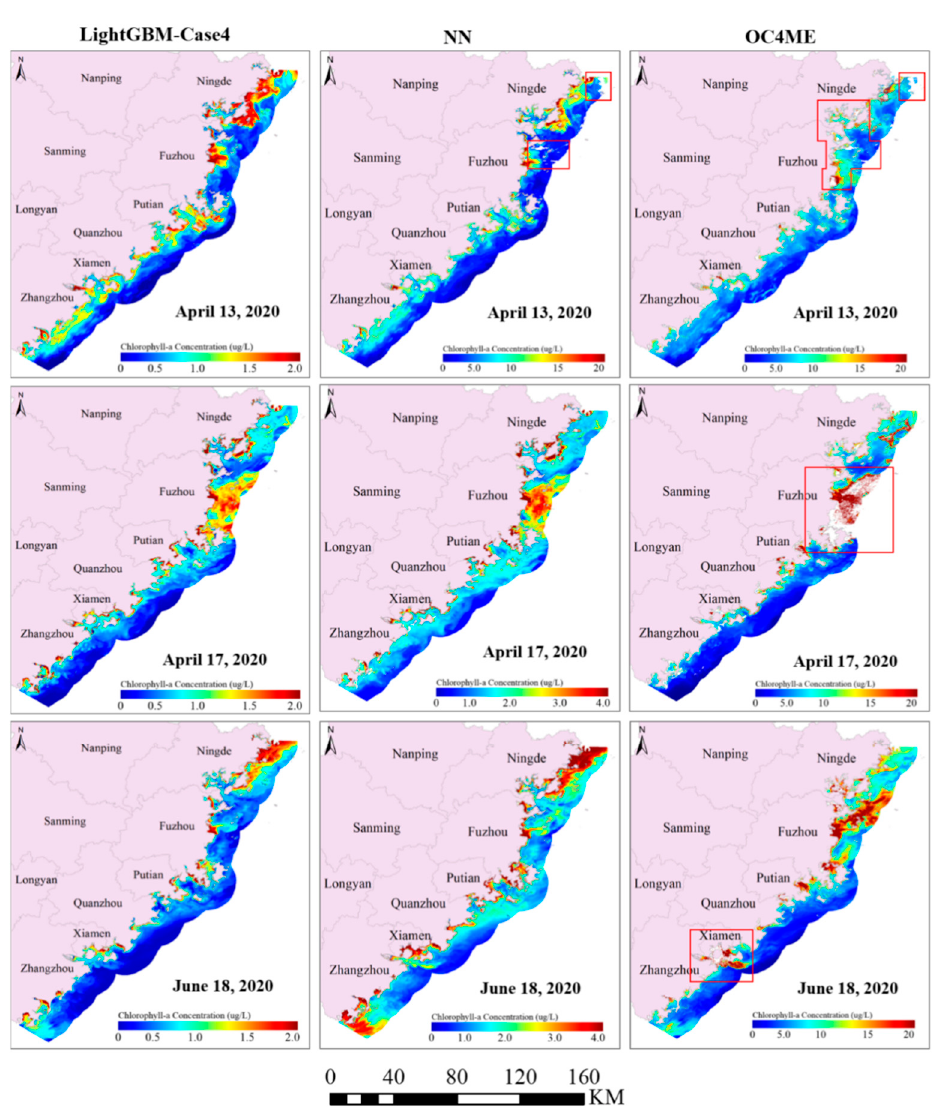
Figure 11 presented the spatial distribution of chl-a concentration based on the LightGBM-Case 4 model, NN algorithm, and OC4ME algorithm. In general, chl-a con- centration values based on NN and OC4ME algorithms are significantly higher than LightGBM-Case 4 estimated values; especially OC4ME estimated values, which were overestimated to 20 ug/L. In fact, the values of chl-a concentration are mainly distributed between 0 and 2 ug/L in the coastal waters according to in situ measurement. The spa- tial distribution of chl-a concentration for the LightGBM model and NN algorithm are generally consistent. However, the OLCI L2 products are not spatially complete, espe- cially the OC4ME products. Figure 11 presented that there are some missing values for chl-a concentration based on the NN algorithm and OC4ME algorithm (shown in the red polygon), while the LightGBM-estimated result is spatially complete. Overall, the LightGBM-estimated product for Fujian’s coastal waters has higher quality than existing OLCI L2 products.